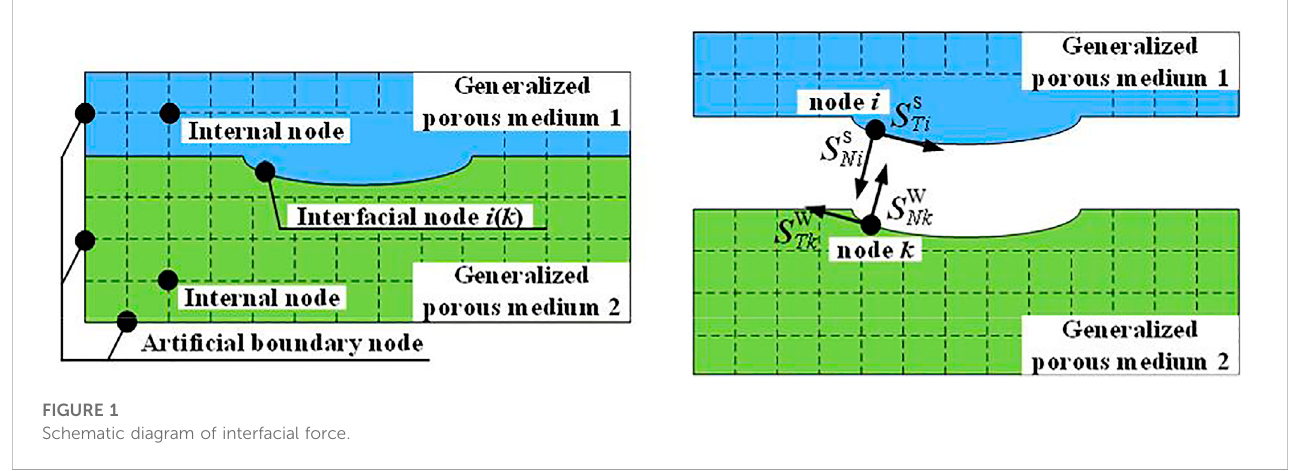
FIGURE 1 Schematic diagram of interfacial